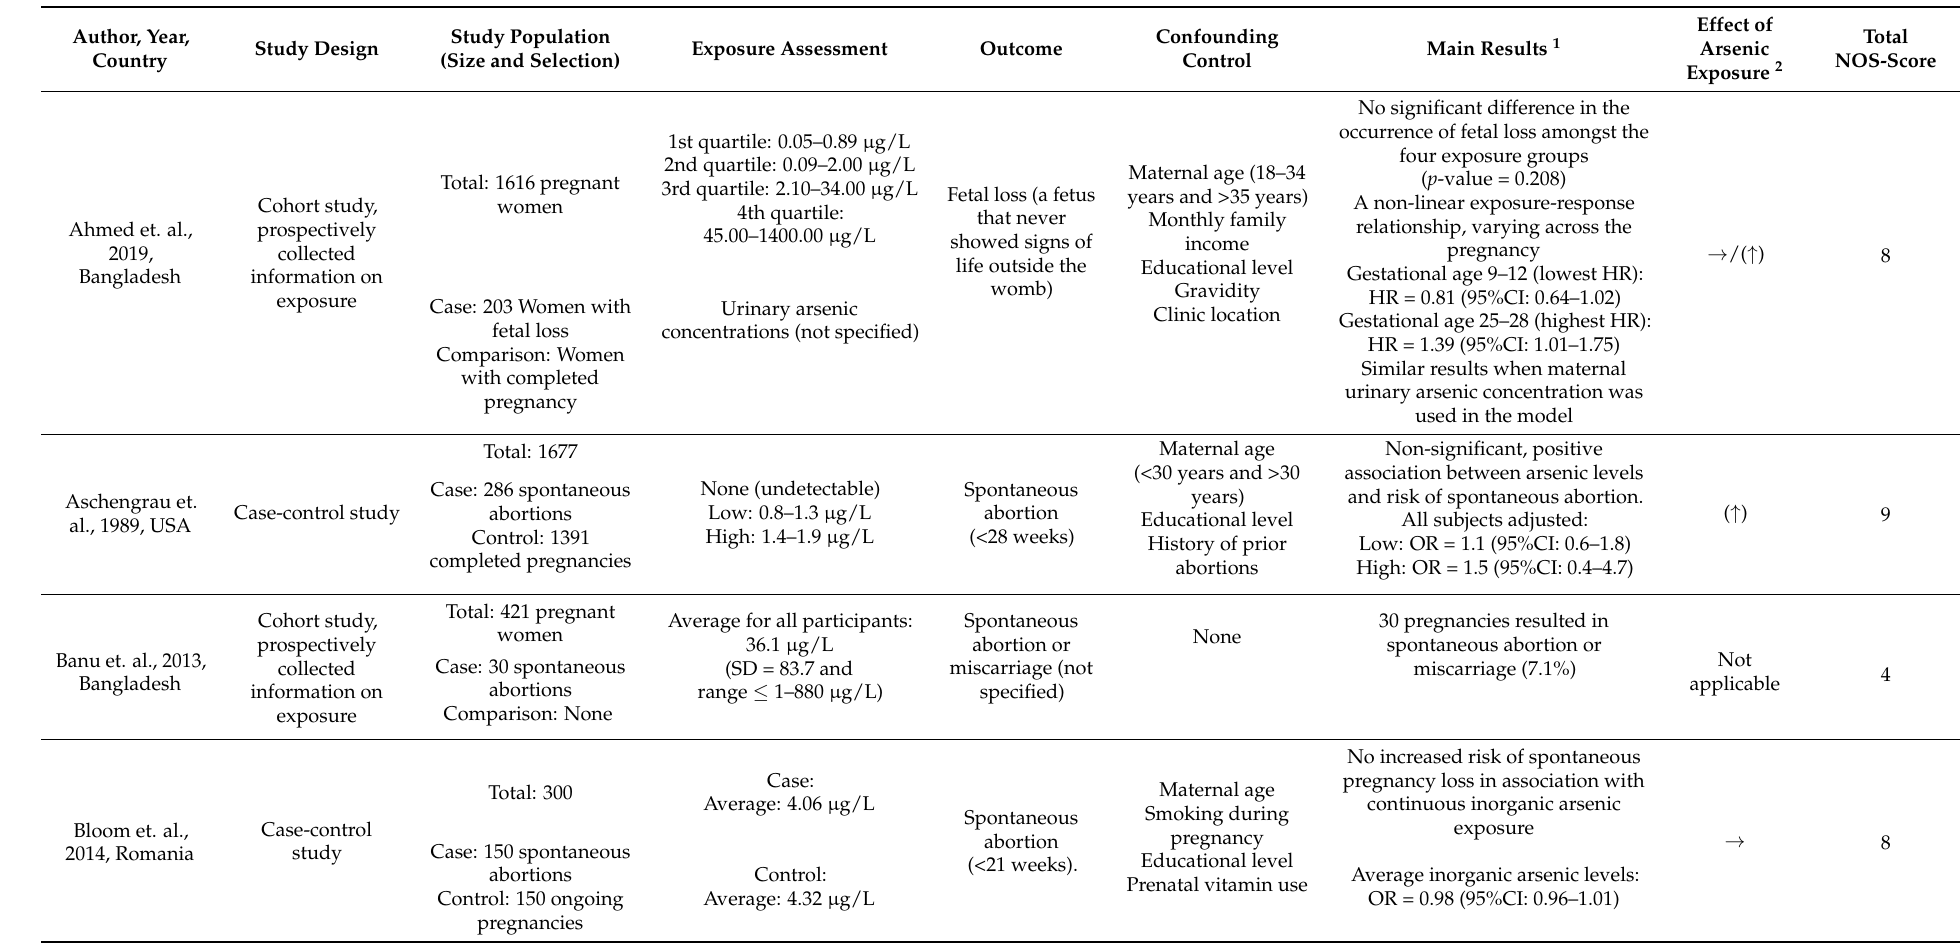
Table 1. Studies Investigating Adverse Reproductive Outcomes in Women Included in the Systematic Review. Characteristics, Results and Assigned Newcastle-Ottawa Scale Score are